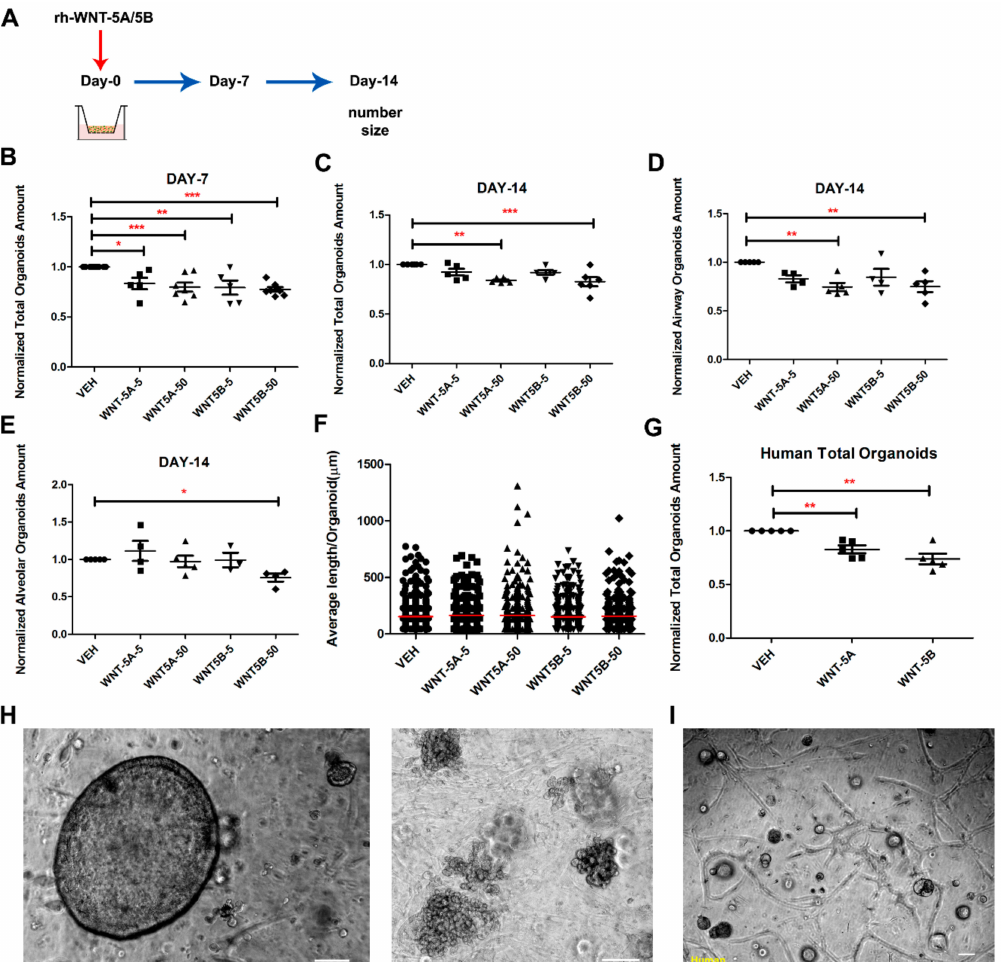
Figure 3. WNT-5A and WNT-5B repressed lung organoids formation and di ff erentiation. ( A ) Schematic of mouse organoid experimental design. ( B ) Quantification of total murine organoids on day 7 treated with recombinant WNT-5A or WNT-5B (0-, 5-, 50 ng / mL), Student t -test. ( C – E ) Quantification of total, airway type, and alveolar type murine organoids on day 14 treated with recombinant WNT-5A or WNT-5B (0-, 5-, 50 ng / mL), Student t -test. ( F ) Quantification of the murine sizes of total organoids measured on day 14 with di ff erent treatments of recombinant WNT-5A or WNT-5B (0-, 5-, 50 ng / mL). n > 330 organoids per group from N = 5 independent isolations, one way ANOVA test. ( G ) Quantification of total human organoids treated with recombinant WNT-5A (50 ng / mL) or WNT-5B (50 ng / mL), Student t -test. ( H ) Representative light microscopy image of murine organoids at day 14. Scale bar = 100 µ m. Airway type of organoids (left), Alveolar type of organoids (right). ( I ) Representative light microscopy image of human organoids at day 14. Scale bar = 100 µ m. Data are expressed as mean ± SEM, * p < 0.05, ** p < 0.01, *** p <